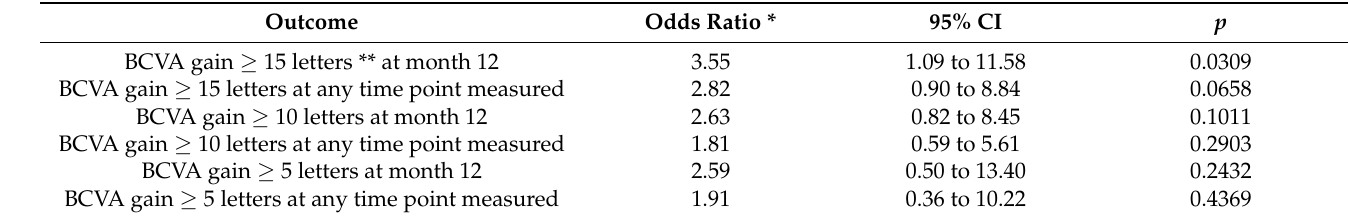
Table 3. Relationship between probability of achieving a given visual acuity gain and treatment- group. The previously treated group was used as the reference for in all variables. Statistical analysis